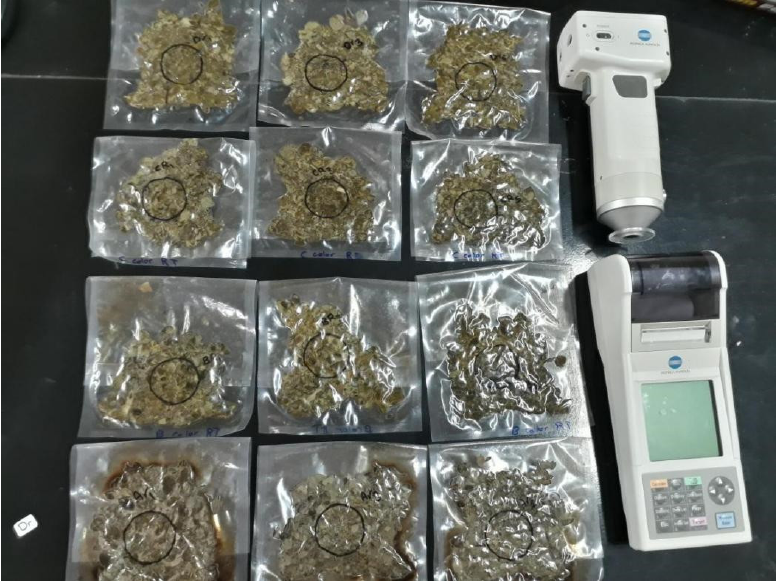
Figure 1. Oregano mix as the finished product was prepared for color index (L*a*b*) measure- ment. Group A: (Control group): (100% Fresh oregano leaves) Group B: (73.2% Fresh oregano, 15% Fresh Allium cepa , 20% corn oil, 1.8%